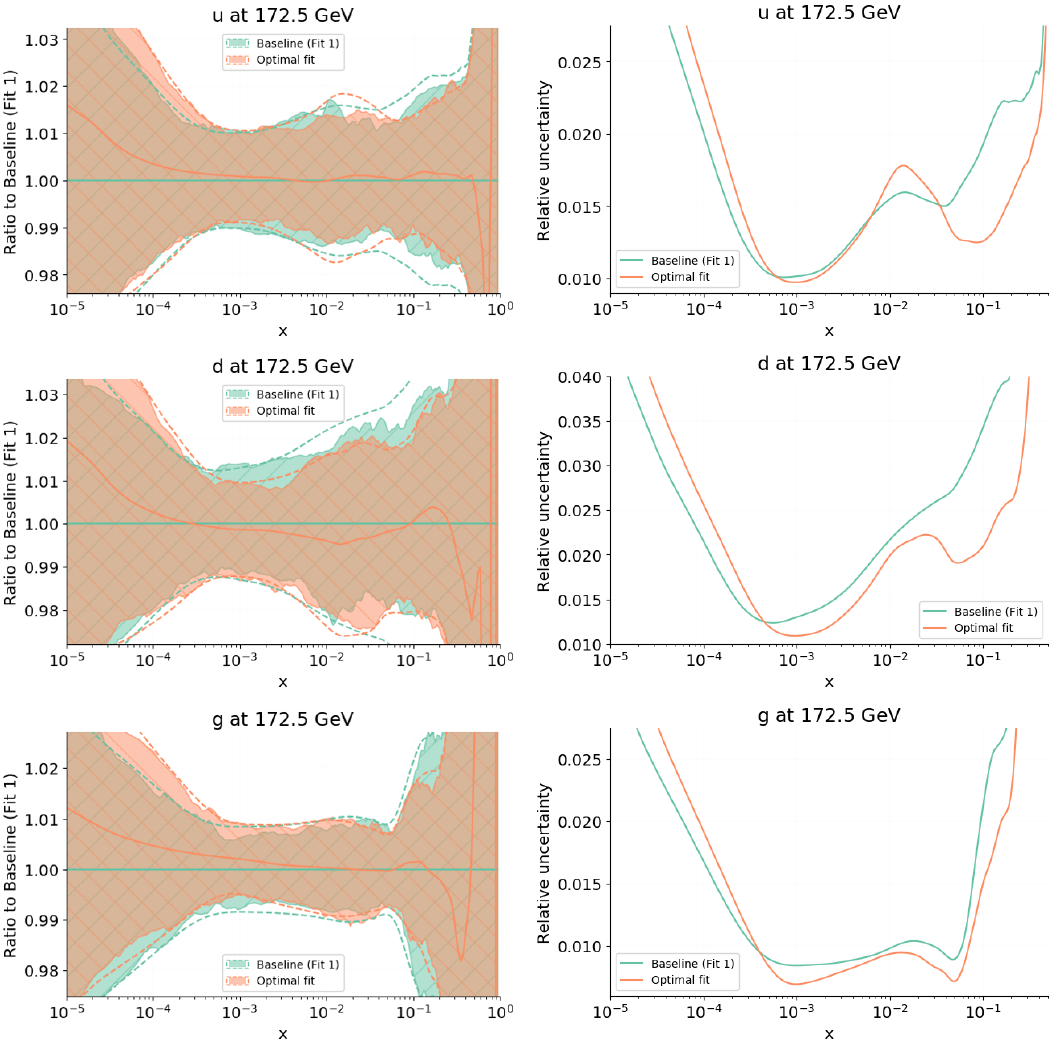
Figure 11 . (Left) PDF plots of the up quark (top), down quark (middle) and gluon (bottom) for two global (cid:12)ts: Fit 1 (baseline) and the Optimal (cid:12)t, as labelled in table 6. Each plot is normalised to the central value of Fit 1, and is shown at Q = m t = 172 : 5 GeV. The PDF uncertainty is shown as both a 68% CL hatched band and a 1 (cid:27) dashed line. (Right) The 1- (cid:27) PDF uncertainties, normalised to their respective PDF central